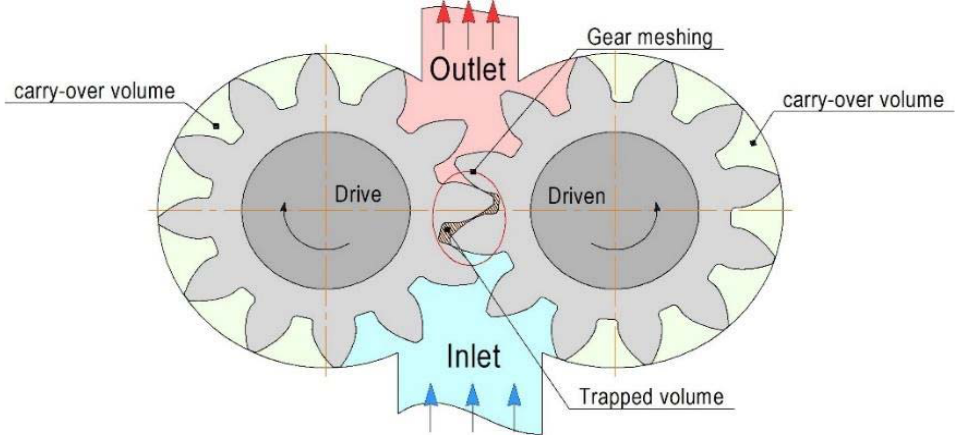
Figure 3. Meridional cross-section of the pump [17]. Table 1. Simulation models’